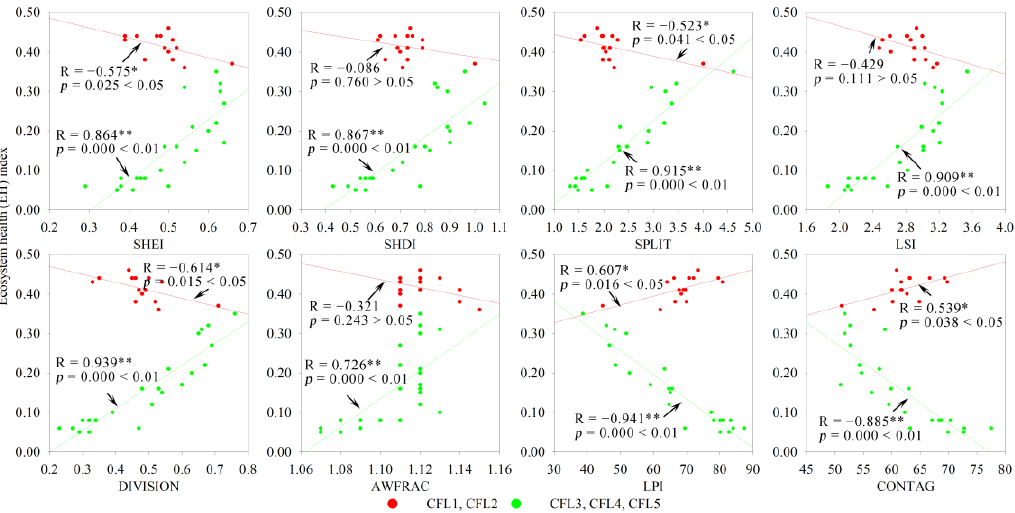
Figure 10. Correlation of landscape composition and configuration with ecosystem health in con- struction land + farmland landscape. CFL, construction land + farmland landscape; SHEI, Shannon’s evenness index; SHDI, Shannon’s diversity index; SPLIT, splitting index; LSI, landscape shape index; DIVISION, landscape division index; AWFRAC, area-weighted mean fractal dimension index; LPI, largest patch index; CONTAG, contagion index. * p -values at 5% level; ** p -value at 1% level.